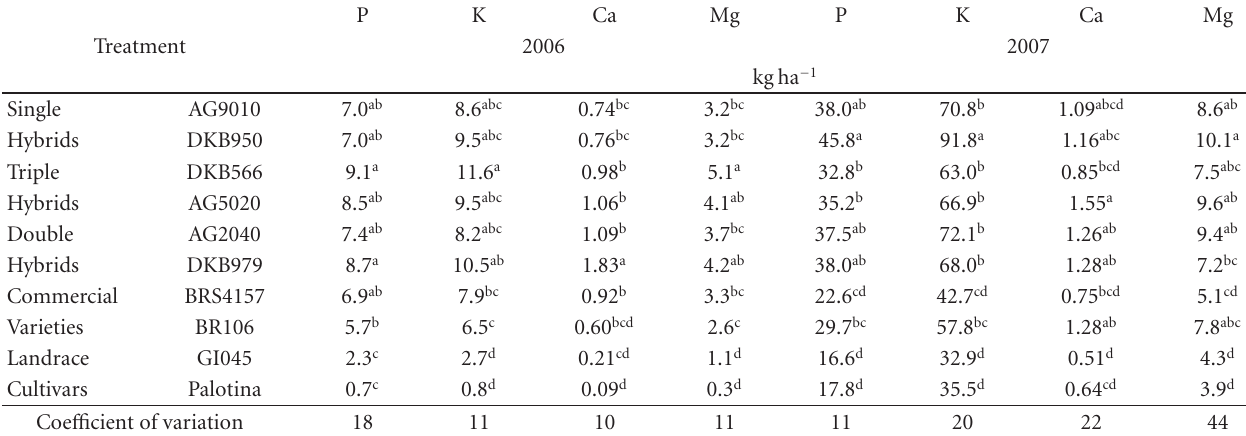
Table 4: Macronutrients exportation of maize cultivars in 2006 and 2007, at Rolandia County, Parana State, Brazil.